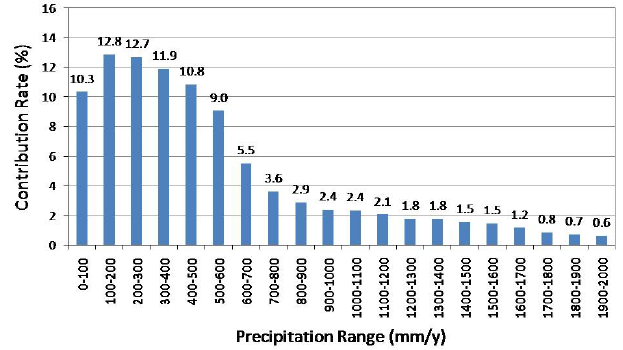
Table 2. Contribution of different mid-latitude region of land- surface temperature trend to global trend, where Europe is